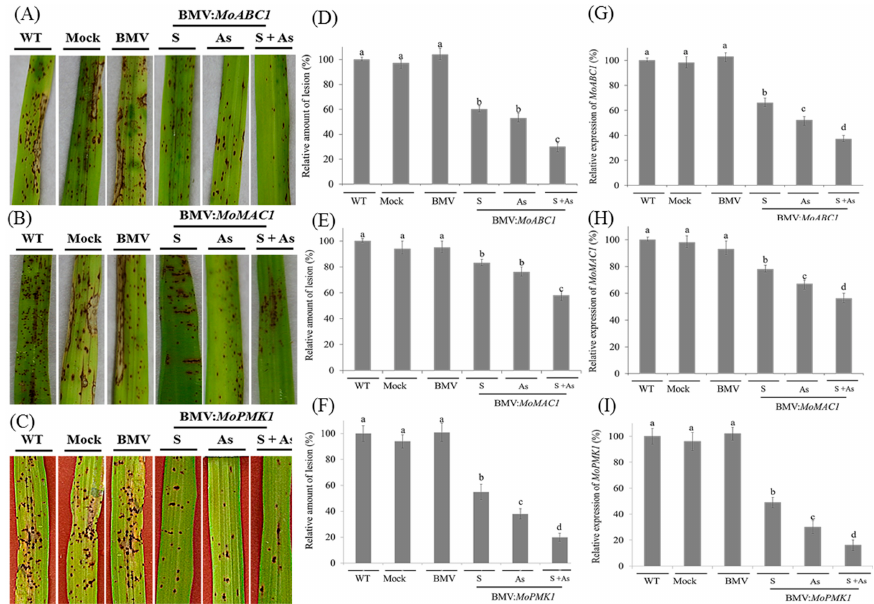
Figure 2. Effects of BMV-derived host-induced gene silencing (HIGS) of targeted M. oryzae genes